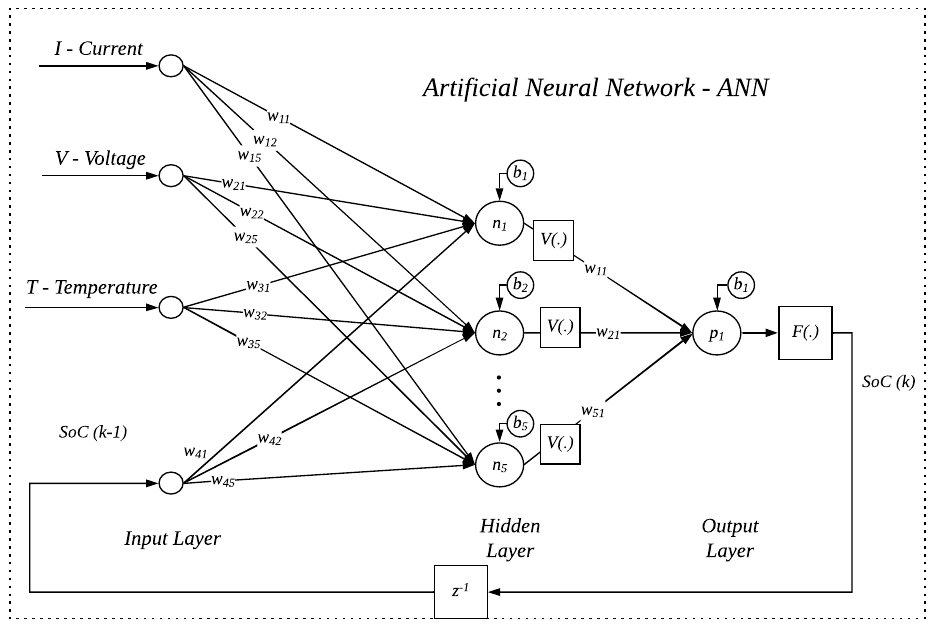
Figure 4. Artificial Neural